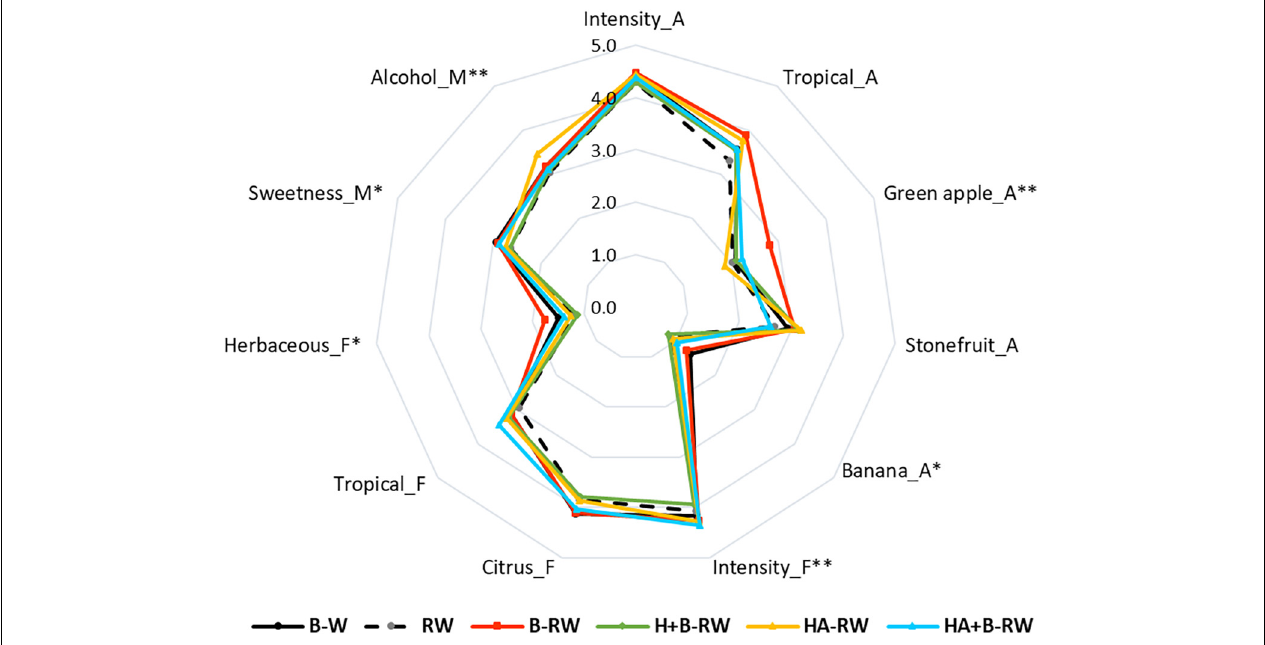
FIGURE 4 | Sensory profiles of wine treated via bentonite fining (B-W), and recombined wines (RW) following ultrafiltration/heat/protease treatments; B denotes bentonite addition; H denotes heating (10 min at 62 ◦ C); A denotes Aspergillopepsin enzyme addition (DSM 0.05% v/v). A, F and M represent aroma, flavor and mouthfeel attributes, respectively. Results are means of panel rating ( n = 54). ∗∗ and ∗ indicate statistical significance at P < 0.05 and P < 0.1 confidence